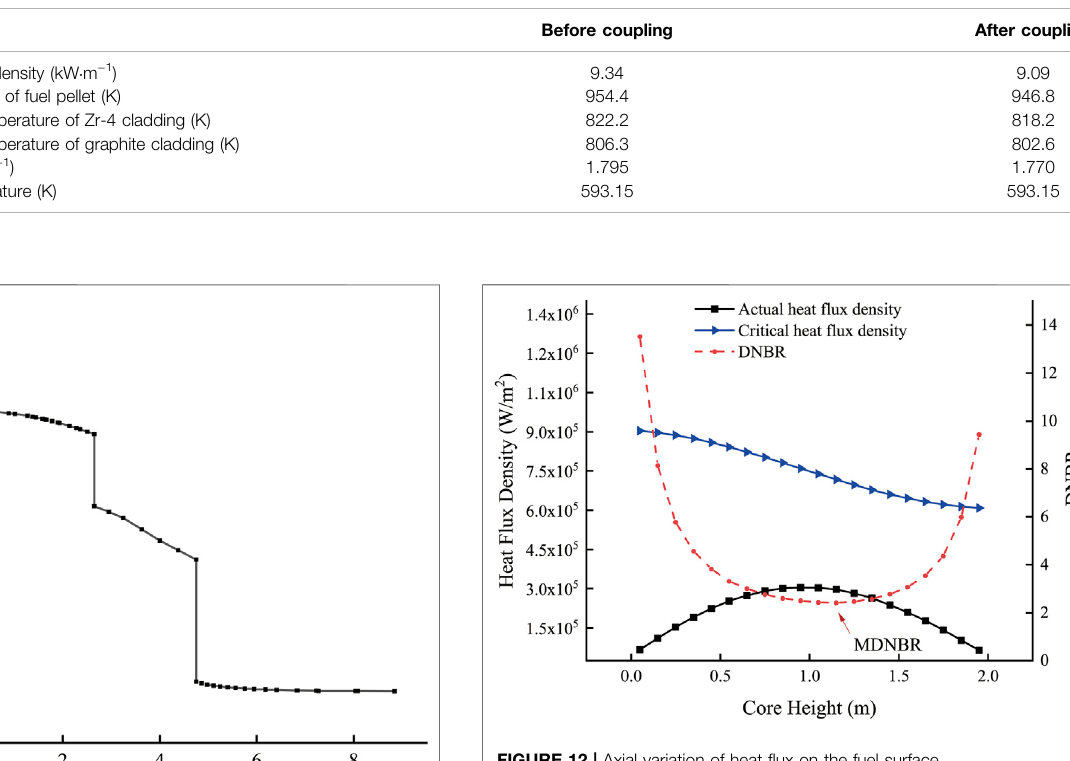
FIGURE 12 | Axial variation of heat fl ux on the fuel